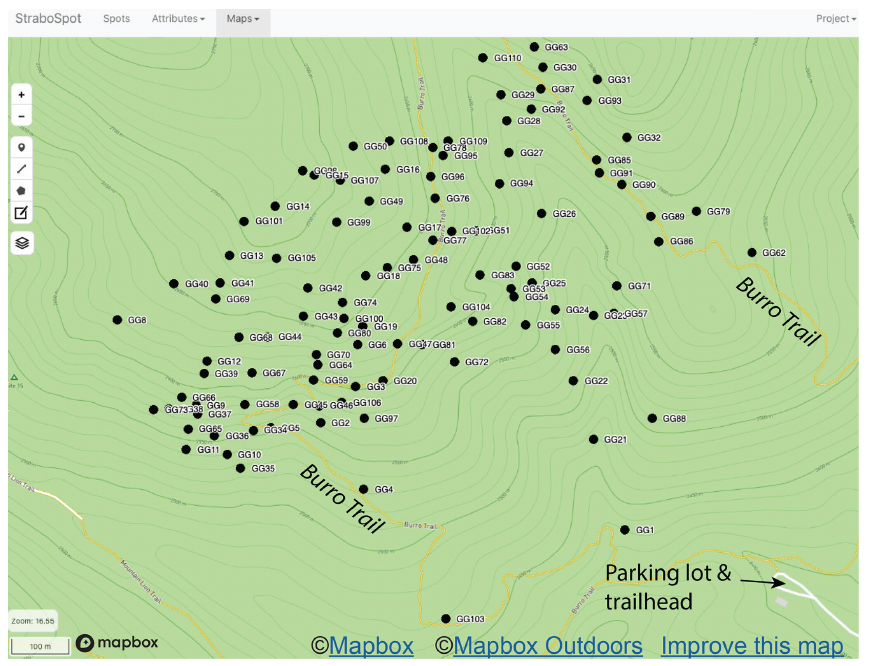
Figure 5. Map view from within a StraboSpot project where the initial shapefile with outcrop locations has been imported. Labels for the parking lot and trails added in larger font for